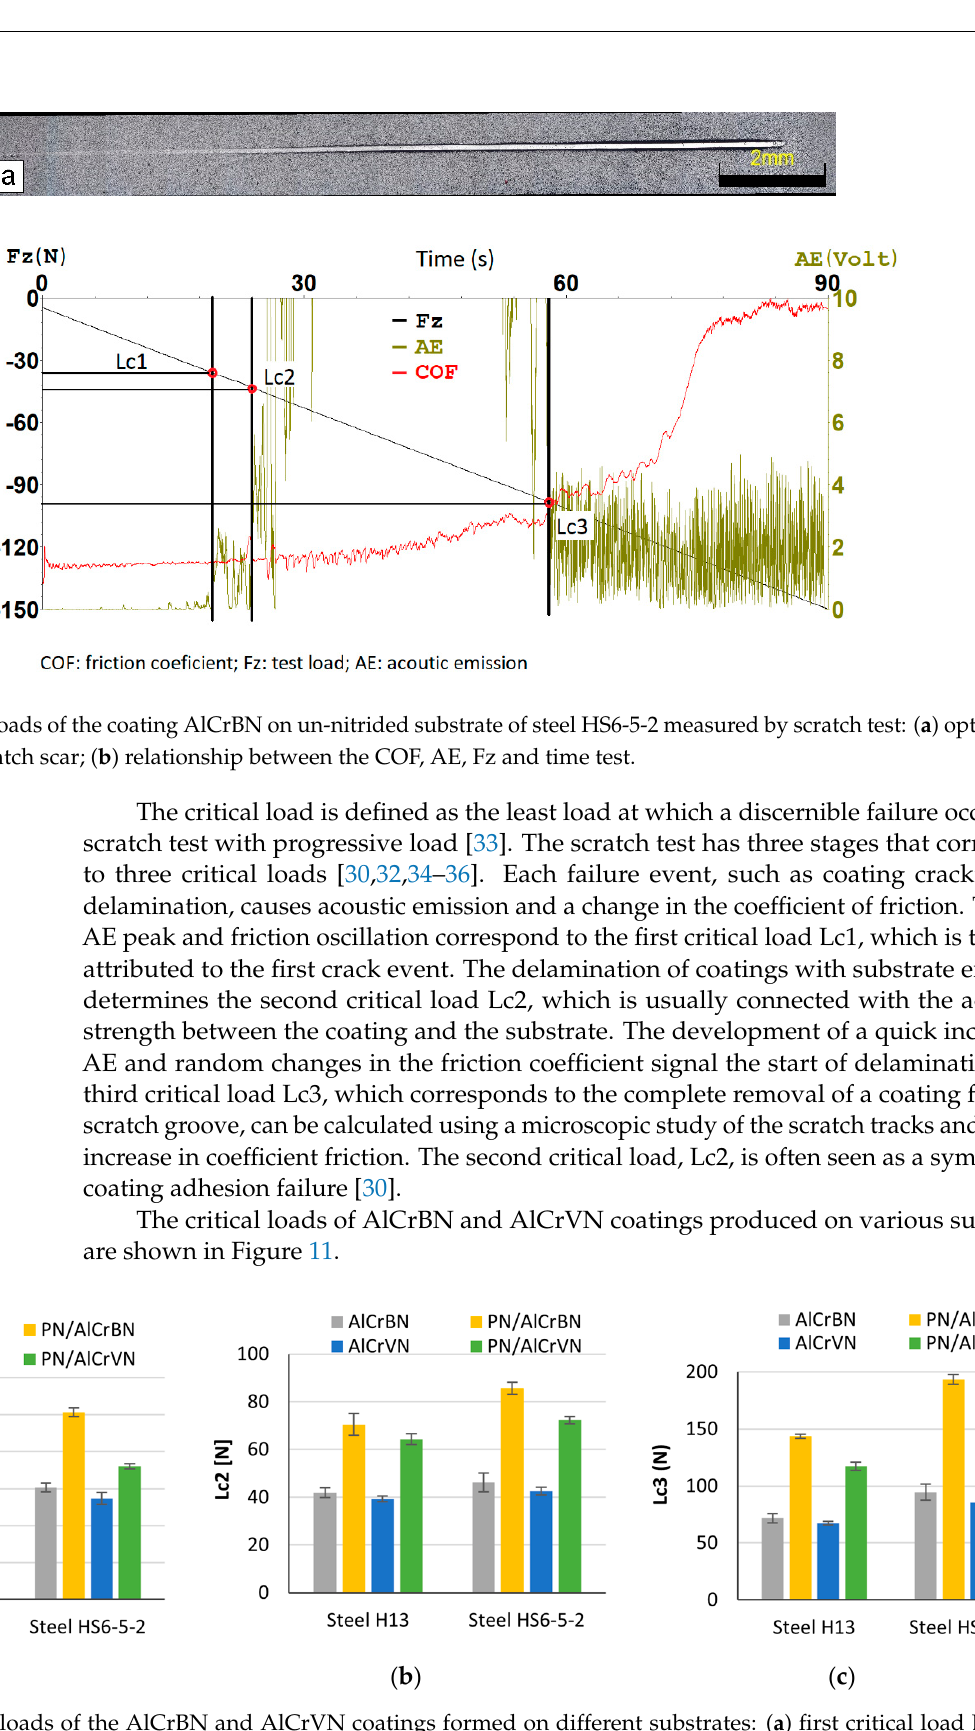
Figure 11. Critical loads of the AlCrBN and AlCrVN coatings formed on different substrates: ( a ) first critical load Lc1; ( b ) second critical load Lc2; ( c ) third critical load Lc3.